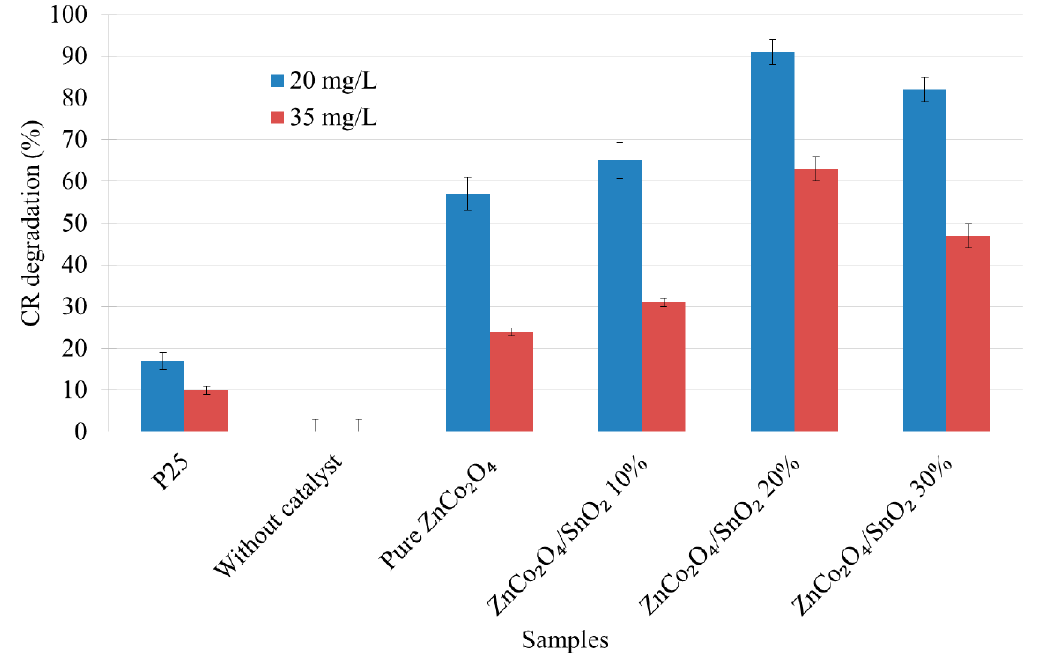
Figure 8. CR degradation (%) without catalyst and for all the samples under visible light ( λ > 400 nm) after 6 h of illumination.